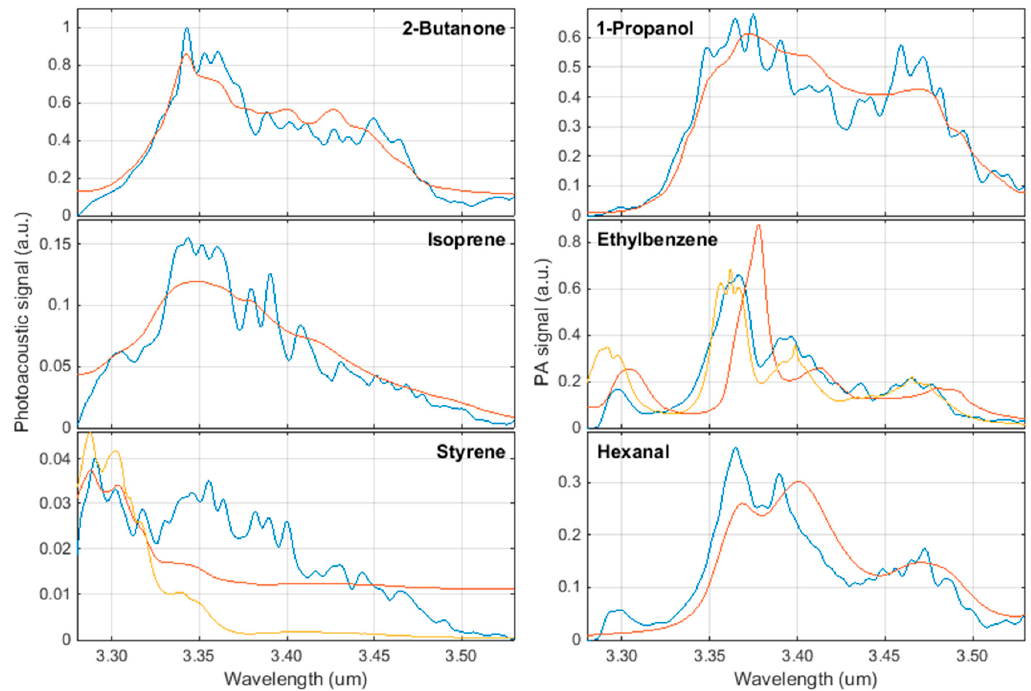
Figure 4. Biomarker spectra ( blue : Measurement; red : NIST; yellow : PNNL) measured at a concentration of 100 ppm in nitrogen at atmospheric conditions (294 K, 1024 hPa).